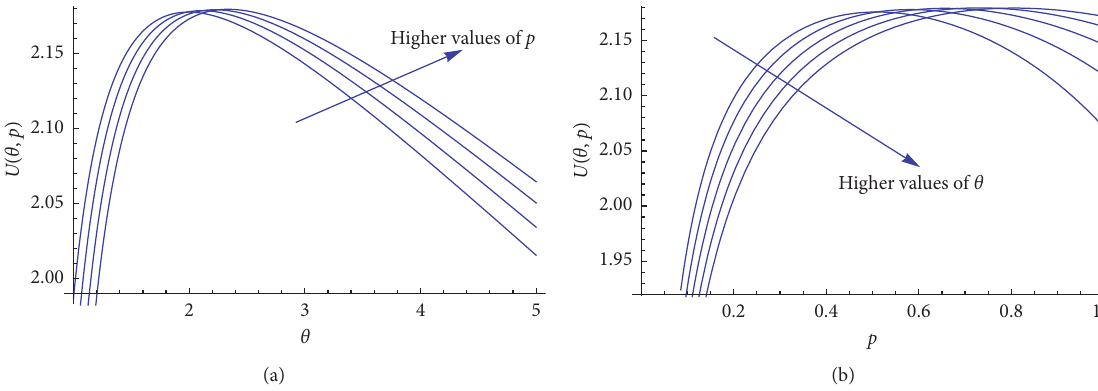
Figure 2: The basic social welfare model: the expected total social welfare U � 0 . 5 , λ � 0 . 6 , β � 0 . 8 , β � 0 . 4 , c � 0 . 5 , and δ � 0 . 0 . 1 , λ 0 1 1 2